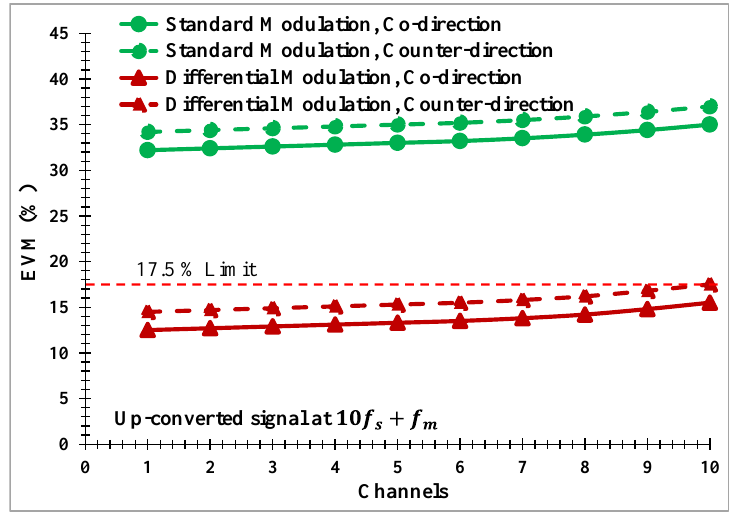
Figure 16. EVM of simultaneous ten up-converted signals at 10𝑓 𝑠 + 𝑓 𝑚 related to the tenth harmonic of the sampling signal at the SOA-MZI output at 100 Gbit/s.